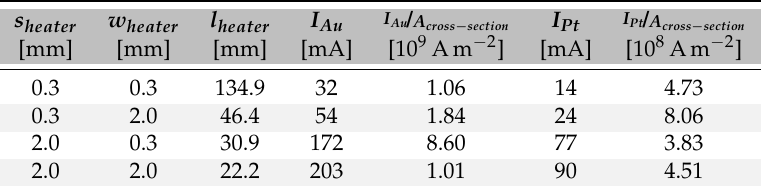
Table 3. Estimated current densities for the 4 extreme heater